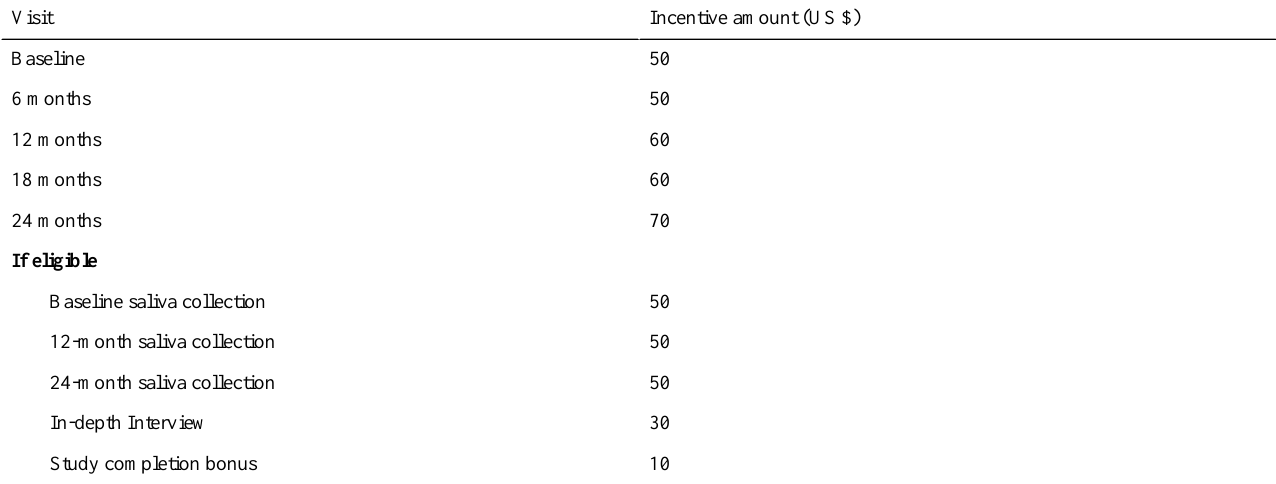
Table 2. Stepped incentive